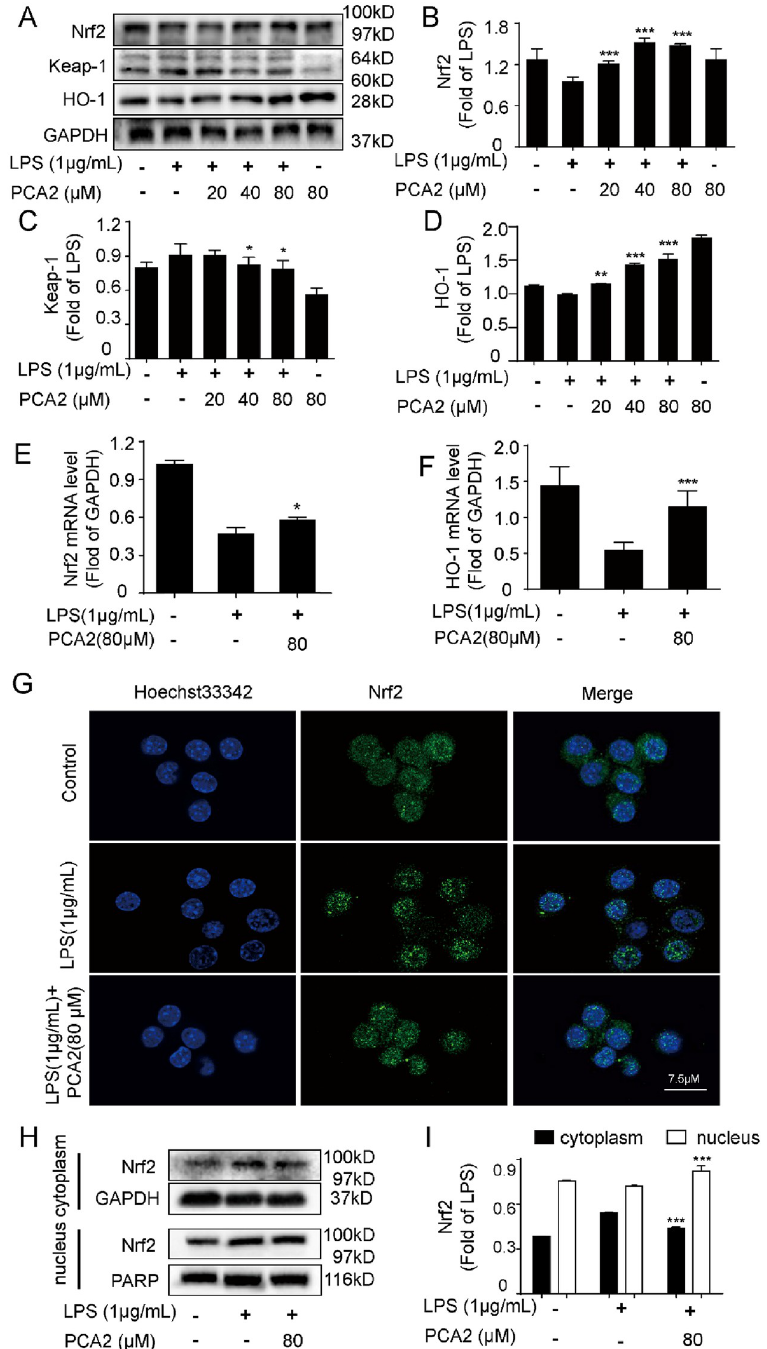
Fig 7. PCA2 attenuated LPS-induced inflammatory activity through Nrf2 pathways. The cell was exposed to PCA2 (20, 40, 80 μ M) for 1 h and cultured with LPS for 8 h, except for the control group. The protein expression of the (A) Nrf2 pathway including (B) Nrf2, (C) Keap-1, (D) HO-1 was measured by western blotting. Cells were co-cultured with LPS for 2 h before treated with PCA2 (80 μ M) for 1 h, except for the control group. (E) Nrf2, (F) HO-1 mRNA level was determined by qRT-PCR (n = 3). (G) The LPS-induced group cells were exposed to LPS for 2 h, while the experiment group cells were exposed to PCA2 (80 μ M) for 1 h and cultured with LPS for another 1 h. Subsequently, cells incubated with Nrf2 antibody and secondary antibody for 1 h independently. Later, we used Hoechst 33342 to stain nuclei for a quarter. Images were taken with the confocal laser scanning microscopy. (H) The cell was exposed to PCA2 (80 μ M) for 1 h and cultured with LPS for 2 h, except for the control group. The protein expressions of Nrf2